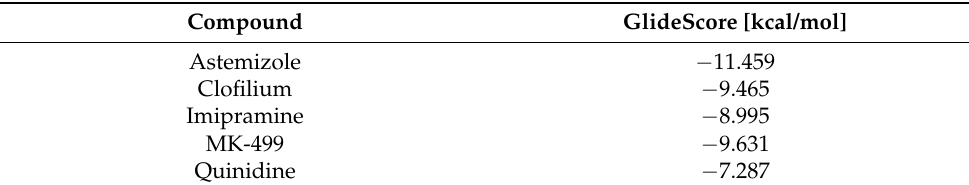
Table 2. Scoring function scores of the K V 10.1 inhibitors investigated in this study.